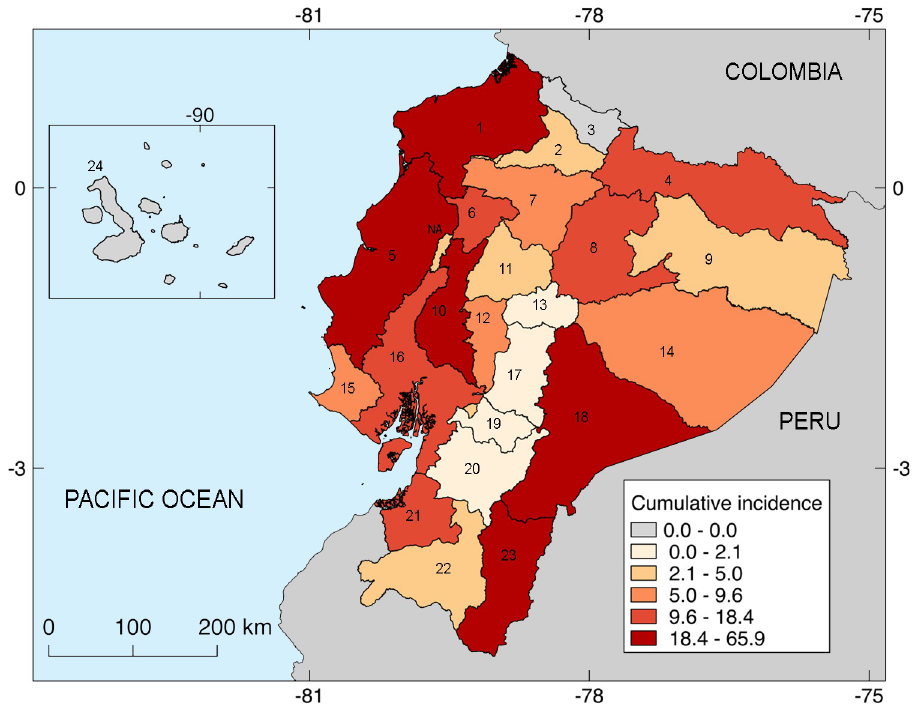
Fig 5. Cumulative incidence of hospitalized cases per 100,000 population by province. The incidence was calculated with the total population of 2020 as denominator. The color ramp on the lower right comprises the spectrum of quintiles for the total incidence. The numbers in the square brackets in the following indicate leptospirosis case numbers corresponding to the numbered provinces on the map: Esmeraldas [No. 1: 186], Imbabura [No. 2: